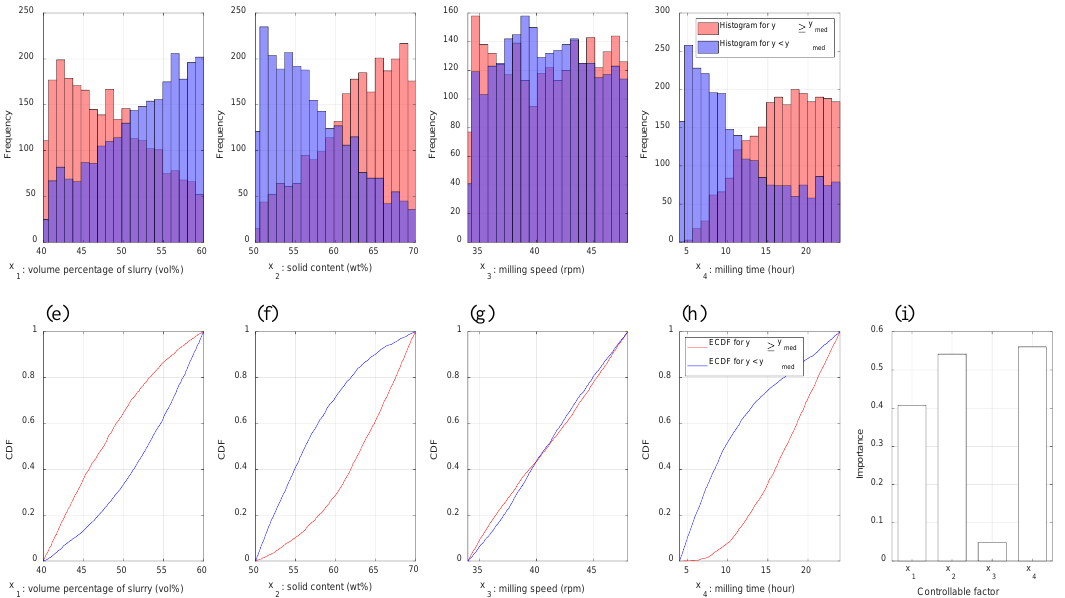
Figure 7. Results of estimating the importance values of controllable factors using the MC-based method: ( a ) histograms for x 1 ; ( b ) histograms for x 2 ; ( c ) histograms for x 3 ; ( d ) histograms for x 4 ; ( e ) ECDFs for x 1 ; ( f ) ECDFs for x 2 ; ( g ) ECDFs for x 3 ; ( h ) ECDFs for x 4 ; ( i ) estimated importance values of four controllable factors.